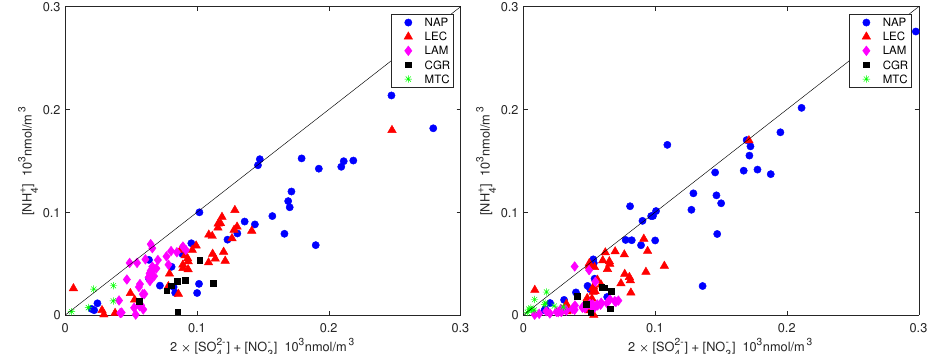
Figure 7. Ammonium plotted against the equivalent sulfate and nitrate molar concentrations for PM 10 ( left ) and PM 2.5 ( right ). The straight line is the 1:1 line.